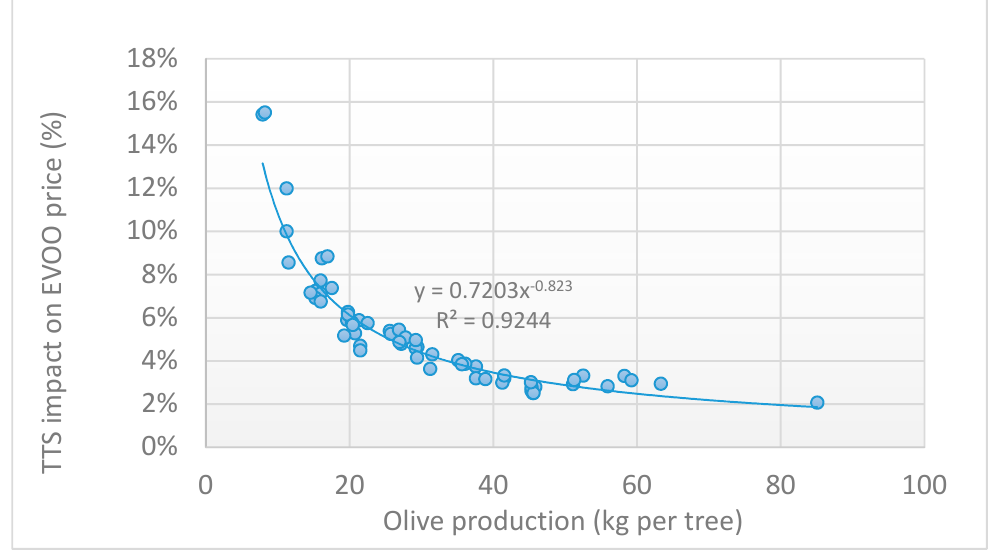
Figure 14. Percentage impact of the TTS application on the EVOO market price as a function of the olive production per tree.